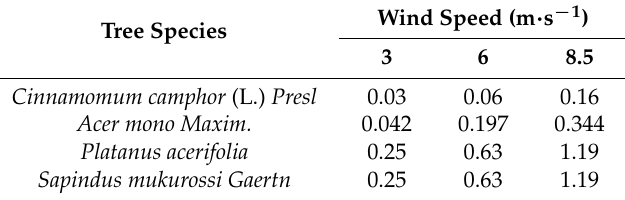
Table 3. Deposition velocities (cm · s − 1 ) of PM 2.5 at different wind speed per unit leaf